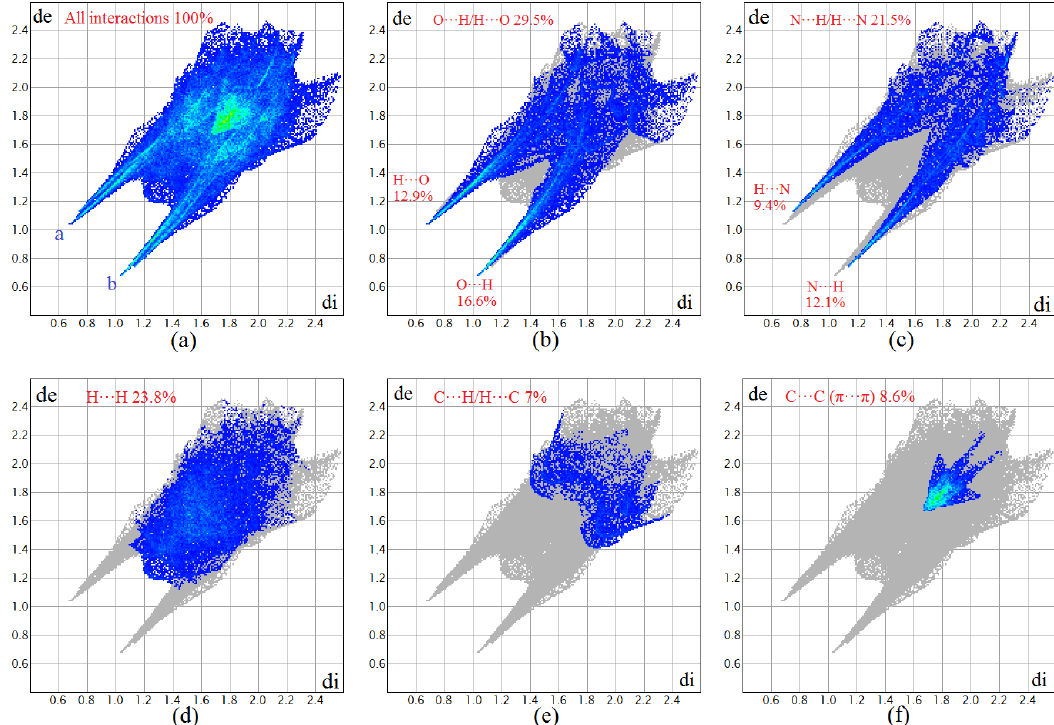
Figure 3. Fingerprint plots of complex 1 : full ( a ) and resolved into O ··· H ( b ), N ··· H ( c ), H ··· H ( d ), C ··· H ( e ) and C ··· C ( f ) contacts showing the percentages of contacts contributed to the total Hirshfeld surface area of molecules.